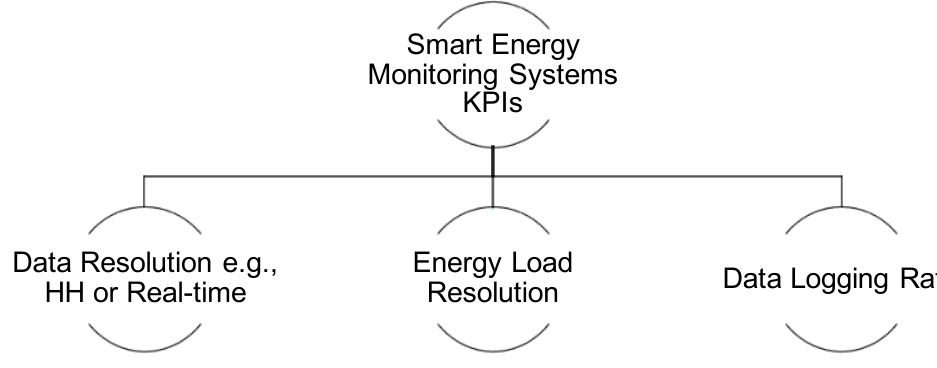
Figure 8. Key performance indicators identified for smart energy monitoring